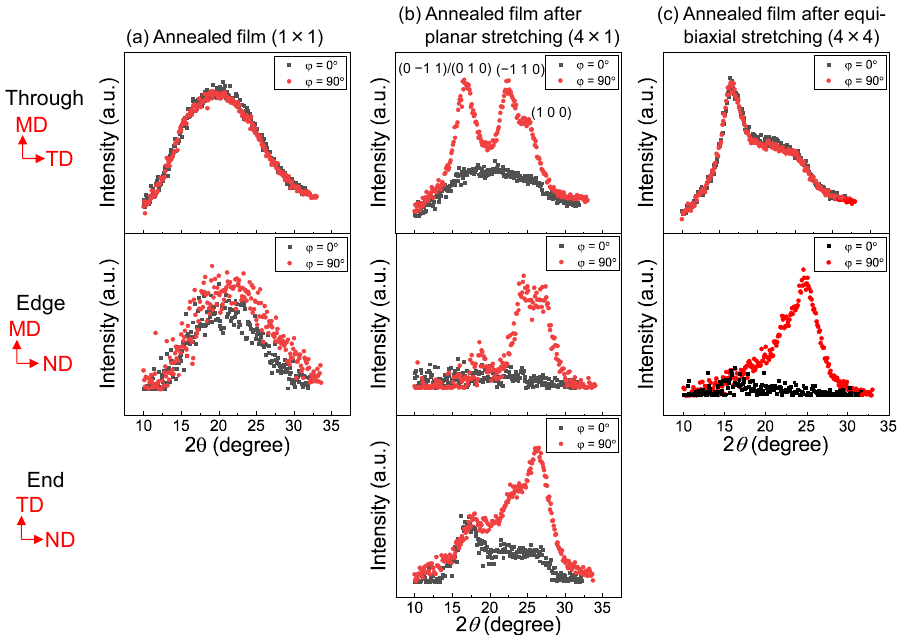
Figure 11. WAXD intensity profiles against diffraction angle for the azimuthal angles ( ϕ ) of 0 and 90° for the ( a ) annealed film (stretch ratio of 1 × 1), ( b ) annealed film after planar stretching (stretch ratio of 4 × 1), and ( c ) annealed film after simultaneous equibiaxial stretching (stretch ratio of 4 × 4).